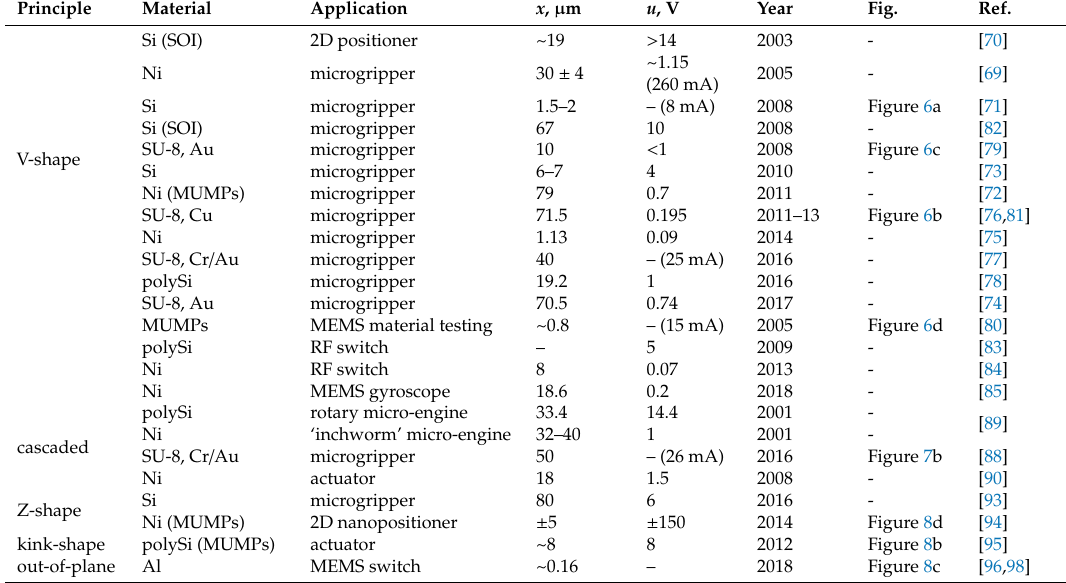
Table 2. Summary of chevron actuators and applications ( x —maximum displacement demonstrated, u —corresponding driving